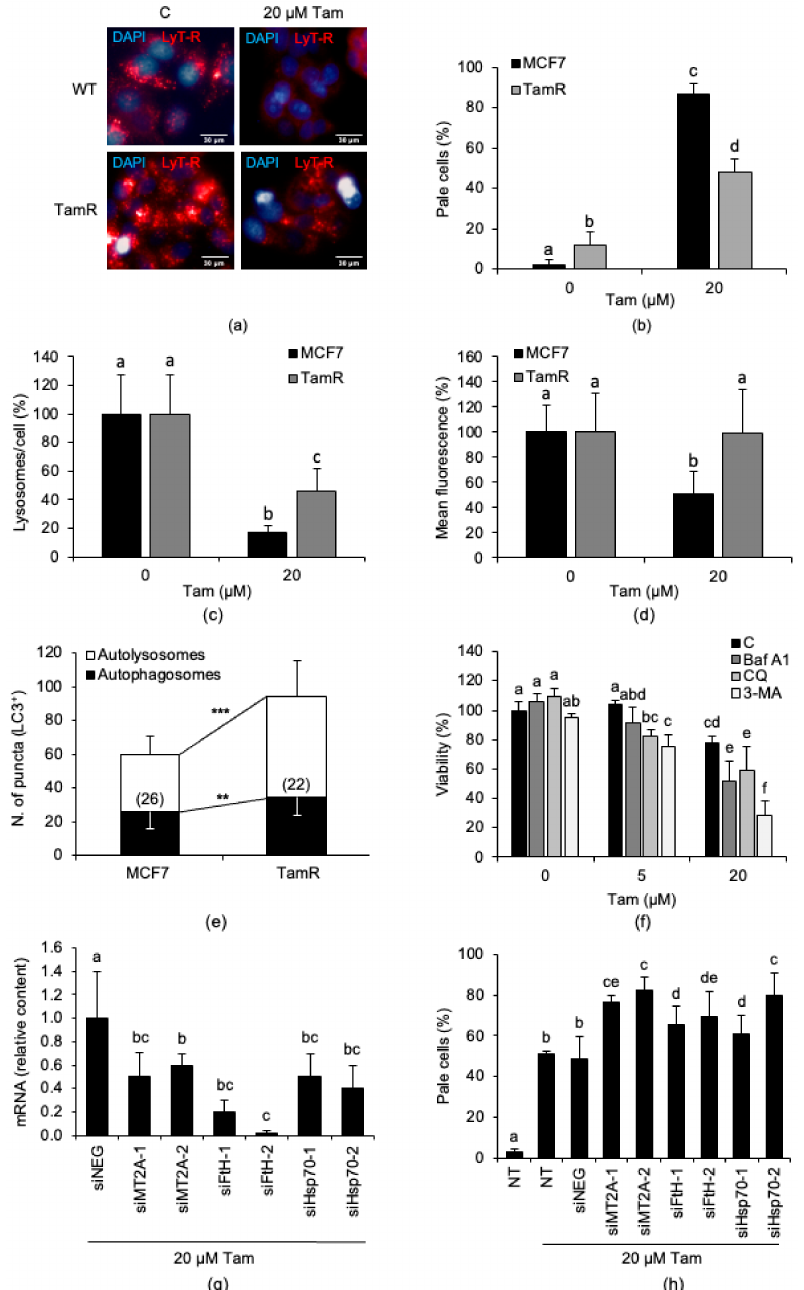
Figure 5. MCF7-TamR cells are resistant to Tam-induced growth inhibition and LMP and show a higher autophagic flux. ( a ) Effect of treatment with 20 µ M Tam for 2 h on LMP in MCF7 and MCF7-TamR cells. ( b ) LMP induced by 20 µ M Tam for 2 h on MCF7-TamR cells. ( c , d ) Effect of treatment with 20 µ M Tam for 2 h on the number of lysosomes/cell ( c ) and the mean lysosomal fluorescence ( d ). ( e ) Autophagic flux in parental and MCF7-TamR cells. The number of cells analyzed is indicated in each bar. ( f ) Effect of autophagy inhibition with chloroquine (CQ, 50 µ M), 3-methyladenine (3-MA, 5 mM), or bafilomycin A1 (Baf A1, 1 µ M) on viability of MCF7-TamR cells exposed to 5 or 20 µ M Tam for 24 h. CQ or 3-MA was added 60 min before Tam; Baf A1 and Tam were added simultaneously. ( g ) Relative content of MT2A, FtH, or Hsp70 messenger RNAs (mRNAs) in MCF7-TamR cells transfected for 72 h with 20 nM of the indicated small interfering RNAs (siRNAs). ( h ) LMP triggered by 20 µ M Tam for 2 h in TamR cells silenced or not for 72 h with 20 nM of indicated siRNAs. WT: wildtype parental MCF7 cells; TamR: MCF7-TamR cells; C: untreated cells. NT: non-transfected cells; siNEG: control siRNA. Data and statistical significance of panels ( b – d ) and ( f – h ) are as in Figure 1; for panel ( e ), the Student’s t -test was used. ** p < 0.05 and *** p < 0.001. Panel ( b ) shows pictures representative of three